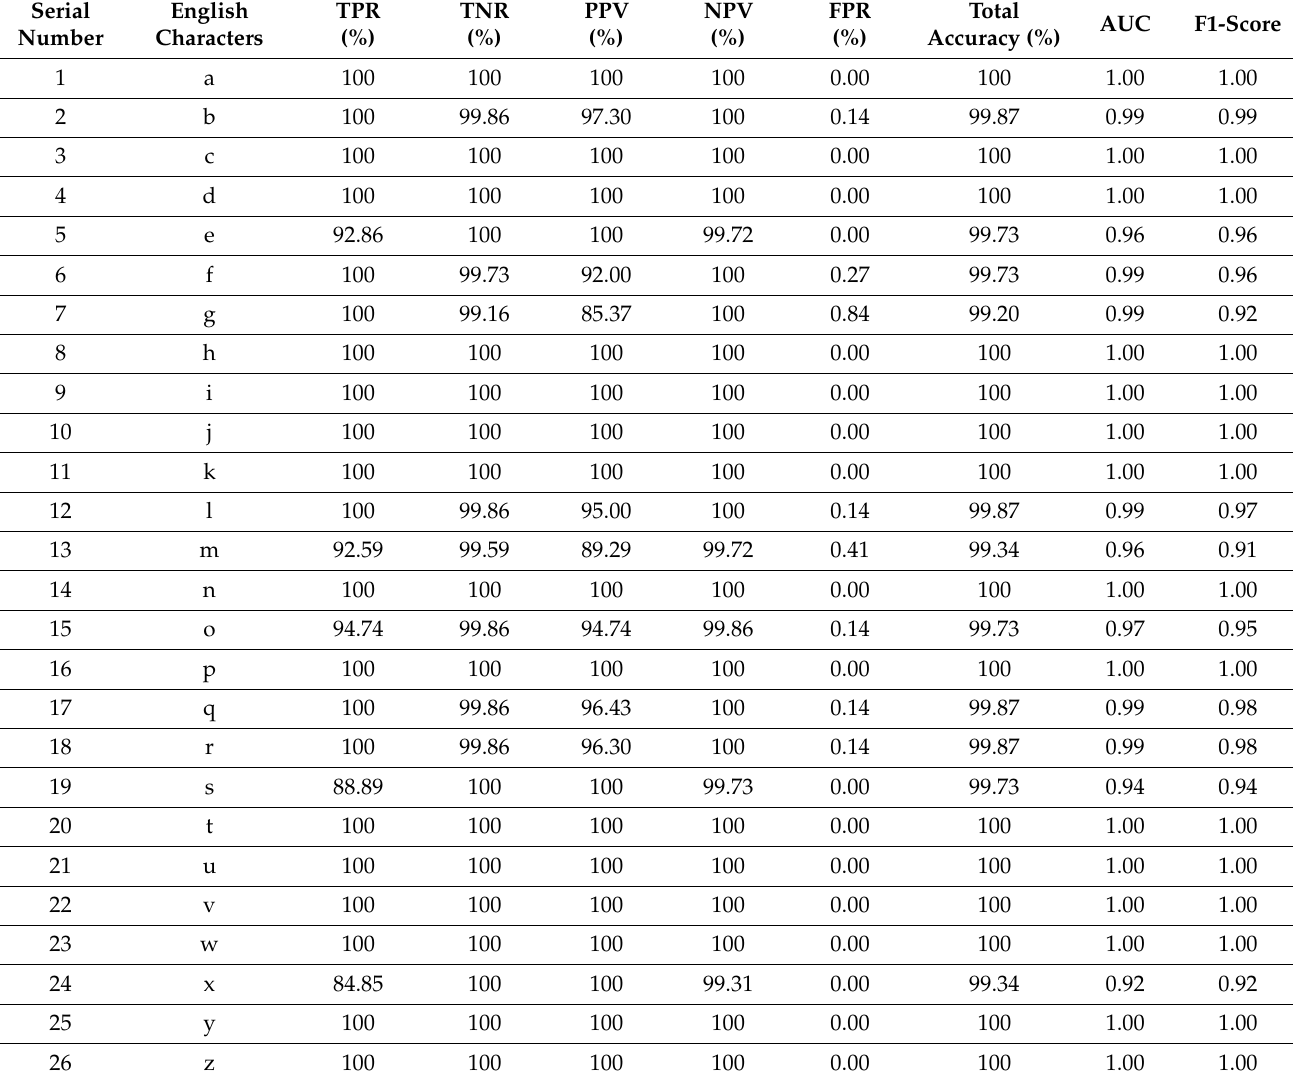
Table 4. Performance metrics showing the results obtained for the SVM classifier.